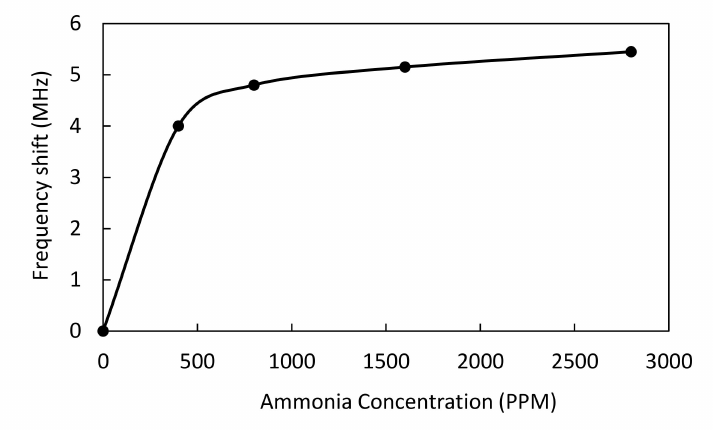
Figure 8. The frequency shift in return loss (S11) in the presence of different concentrations of NH 3